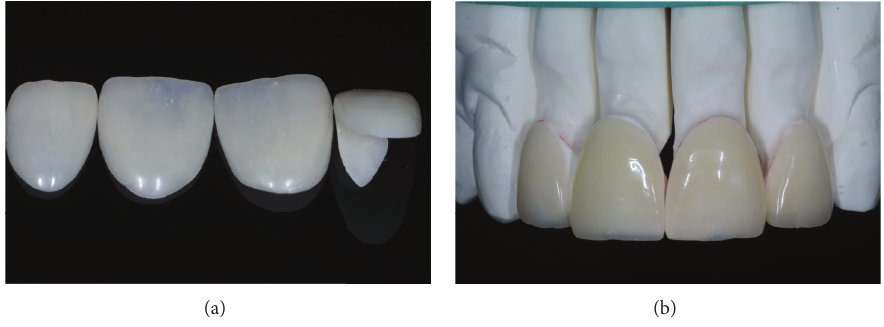
Figure 14: (a)-(b) Finished and polished restorations.